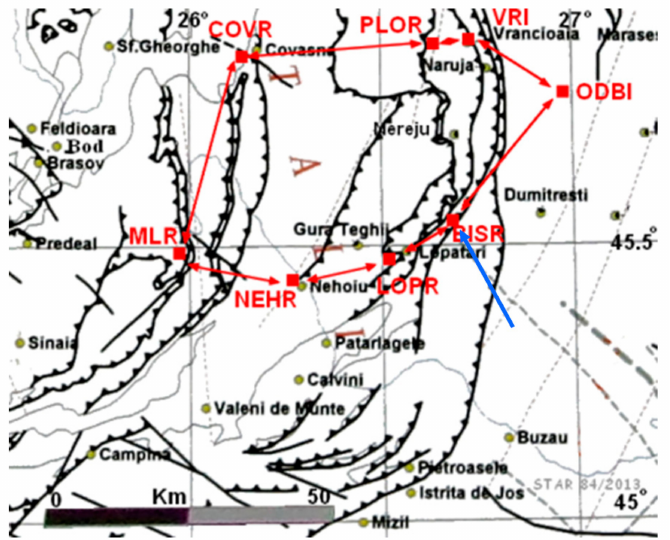
Figure 18. Monitoring network, main faults (map by C. Dinu, V. Raileanu et